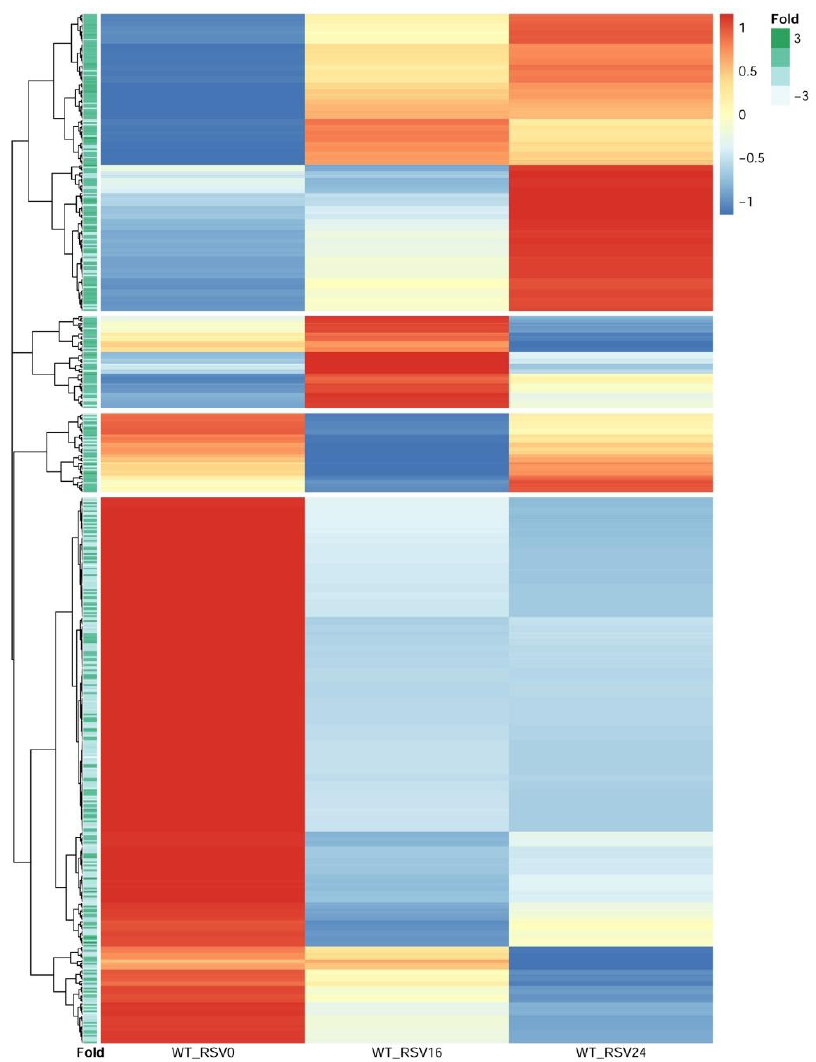
Figure 9. mRNA expression changes associated with RSV-induced changes in chromatin accessibility. mRNA expression patterns of genes within 3000 bp of RSV induced nucleosome free regions were scaled and grouped by hierarchical clustering using Euclidian distance as the distance metric. Each row represents a different gene. Four distinct expression patterns are separated by white space. Bottom left, the “Fold” annotation column indicates the fold change in accessibility of the nearest ATAC-seq peak to the TSS. Note the higher accessibility scores tend to occur in the top 2 clusters; expression of these genes is increased by RSV infection.